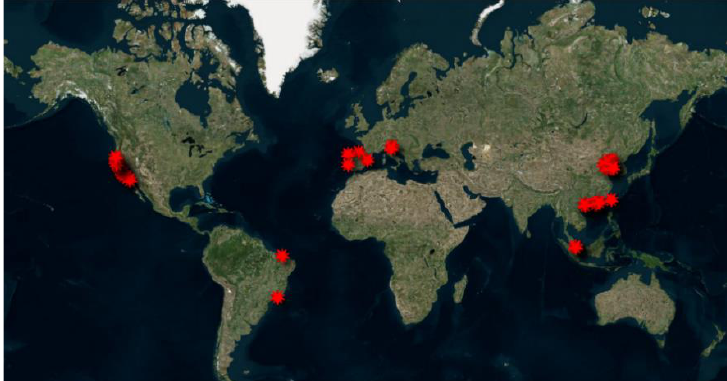
Figure 2. Sampling points of bivalves for antibiotic analyses all around the world.